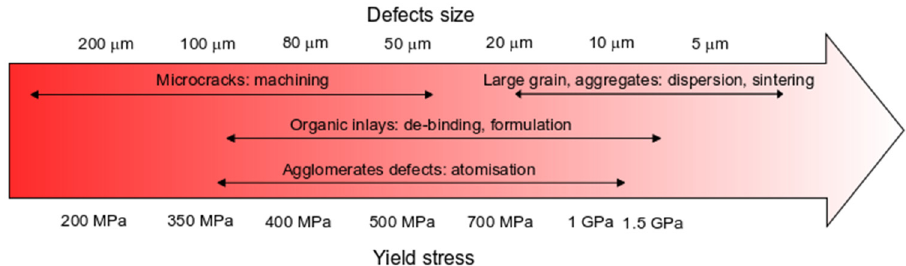
Figure 1. Evolution of yield stress in relation to the defect size for ceramic toughness of 6 MPa m 1/2 . Green Ceramic Machining (GCM) consists of machining the compacted ceramic pow-